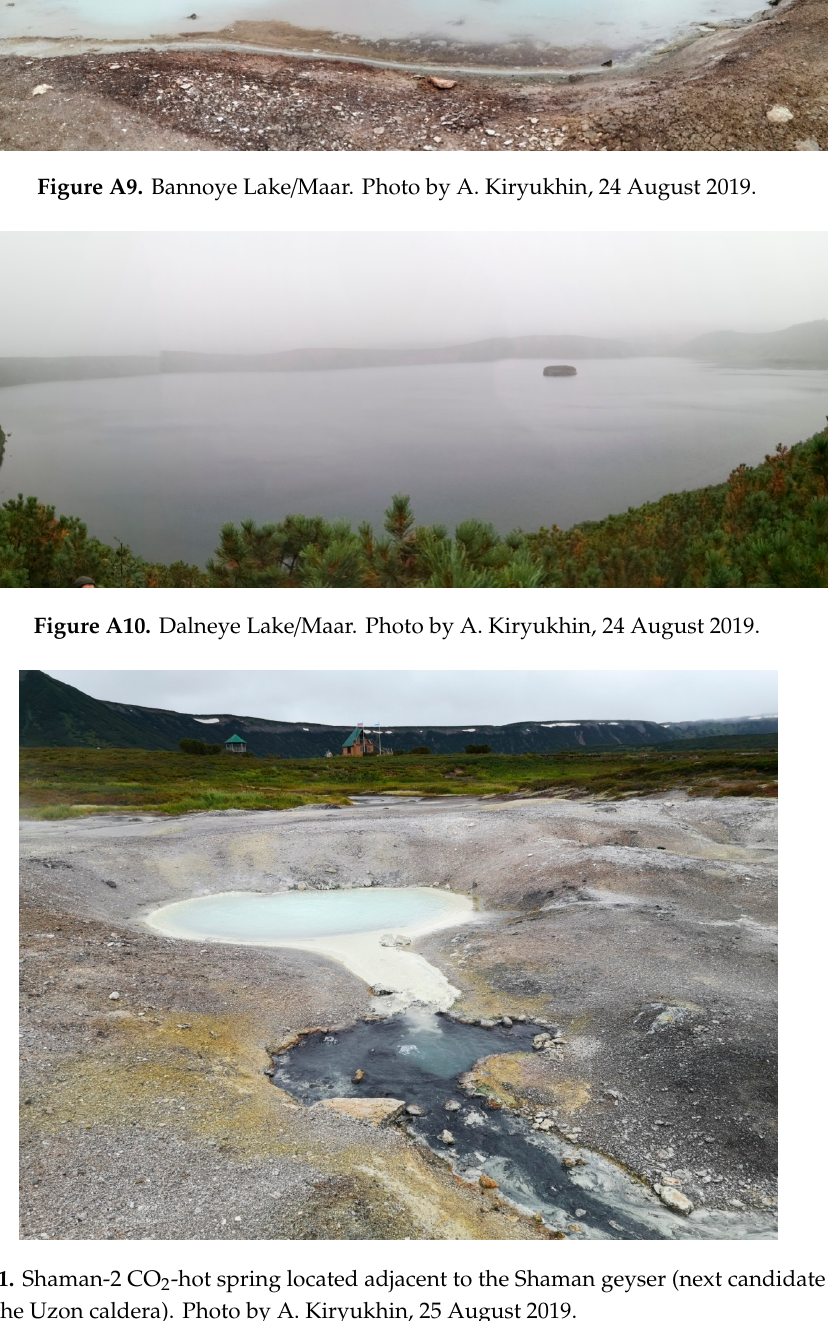
hydrothermal (phreatic) and geyser eruptions at Yellowstone National Park. USA Geol. 2016 , 44 , 235–238.